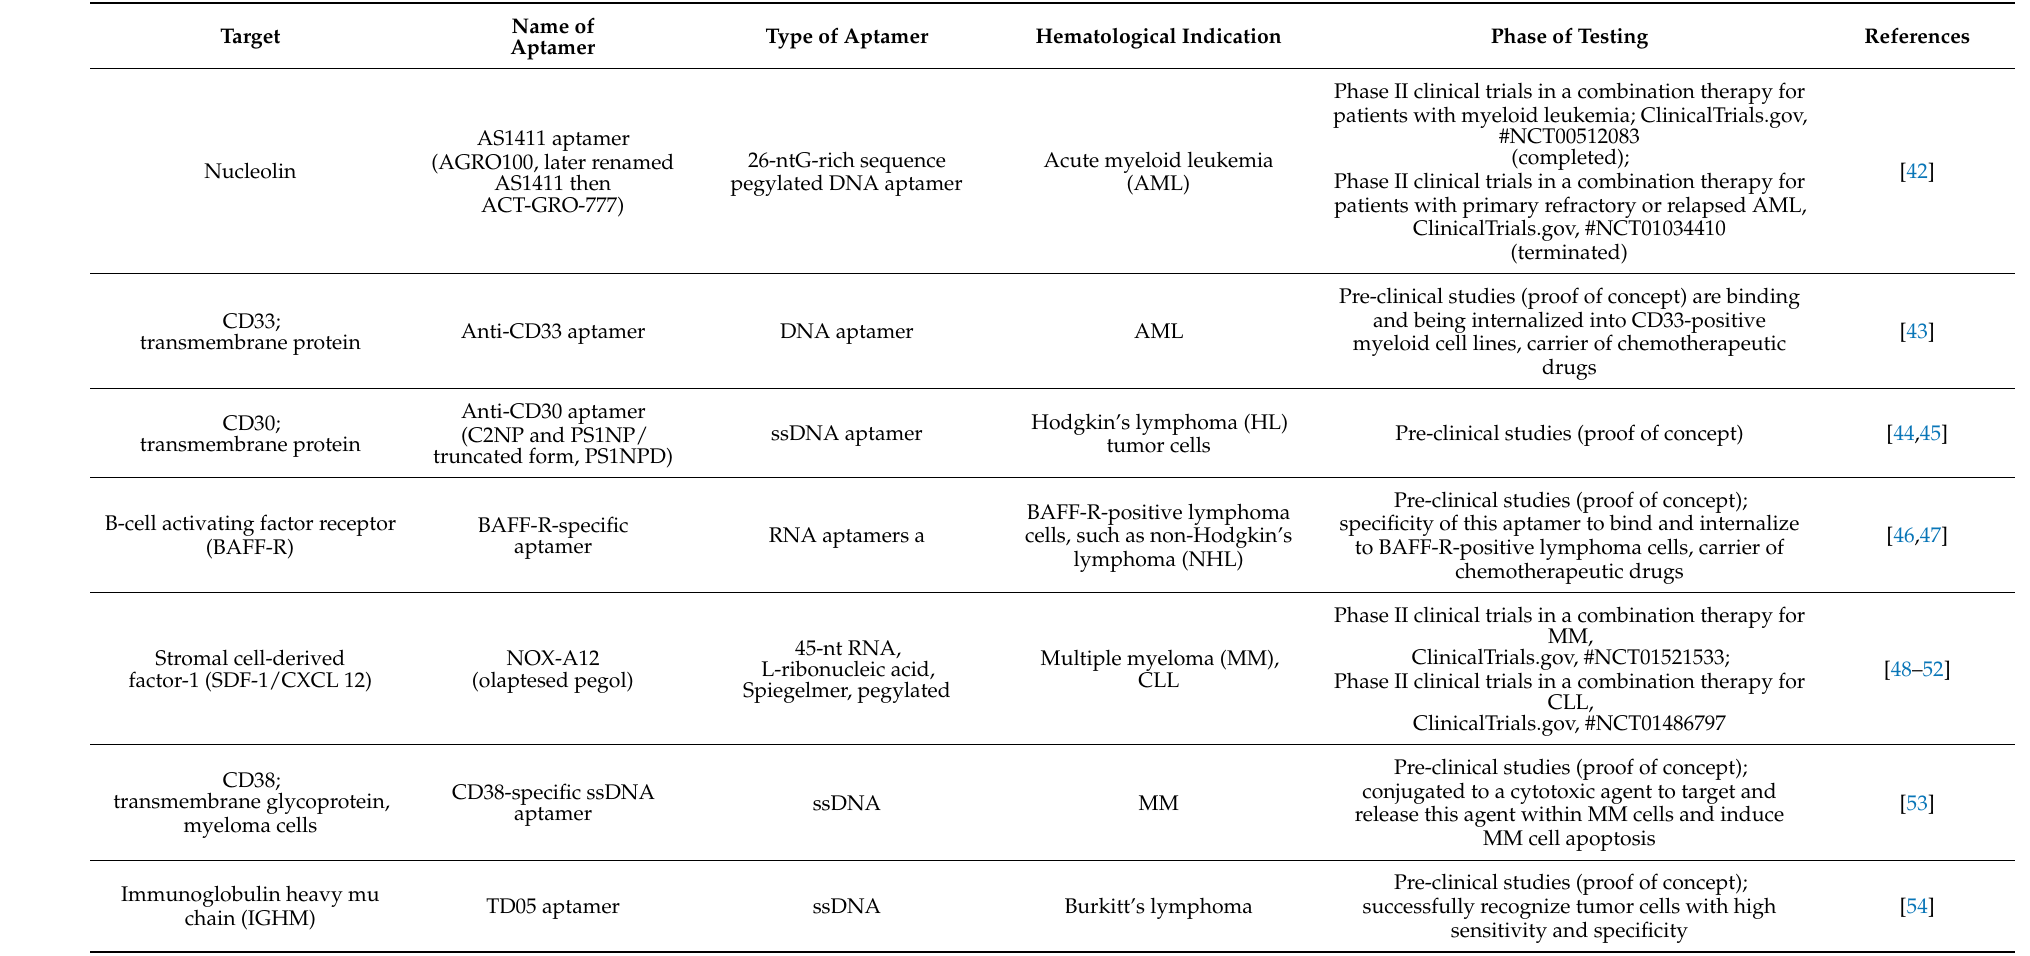
Table 2. Summary of different pre-clinical and clinical-stage aptamers for blood